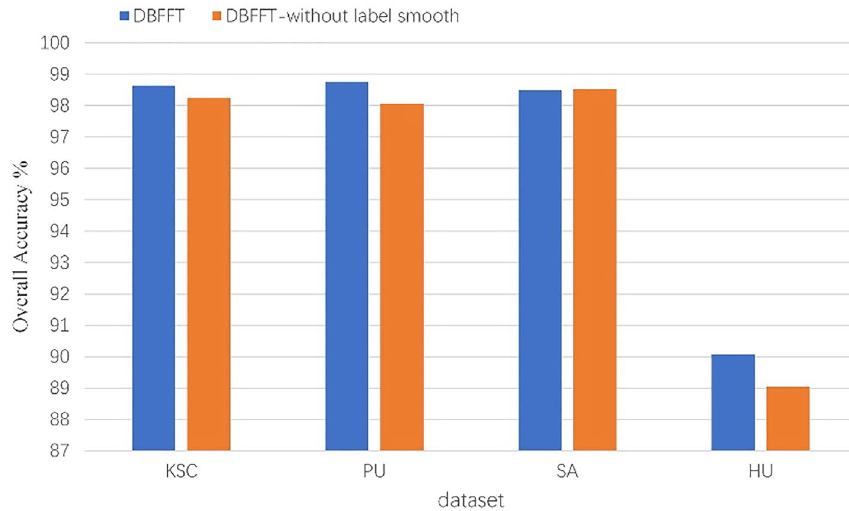
Figure 18. The effect of label smooth on the performance of the model.